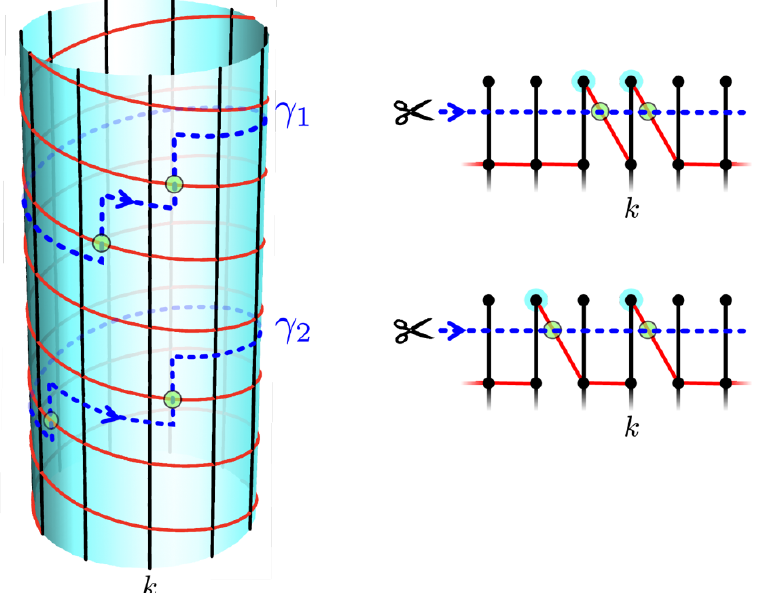
Figure 5 . Two possible cuttings of the two point function of two local operators O . Each cutting represents the same two point function as a contraction of two CFT wave functions. The two cuts produce di(cid:11)erent ordering of the magnons inside the chain. The cut (cid:13) 1 leads to the wave function (3.1) with f I k +3 ; I k +2 ; I k +1 ; I k ; I k (cid:0) 1 ; I k (cid:0) 2 g = f 0 ; 0 ; 1 ; 1 ; 0 ; 0 g , while the cut (cid:13) 2 leads to the equivalent wave function with f I k +3 ; I k +2 ; I k +1 ; I k ; I k (cid:0) 1 ; I k (cid:0) 2 g = f 0 ; 1 ; 0 ; 1 ; 0 ; 0 g